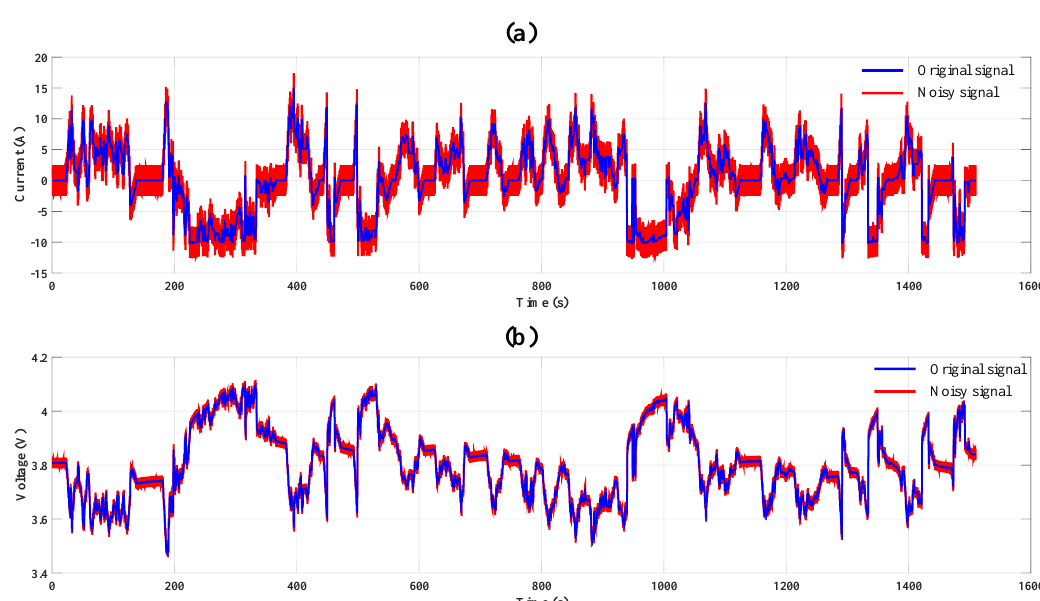
Figure 11. Voltage and current signals: ( a ) original and noisy current signal and ( b ) original and noisy voltage signal.